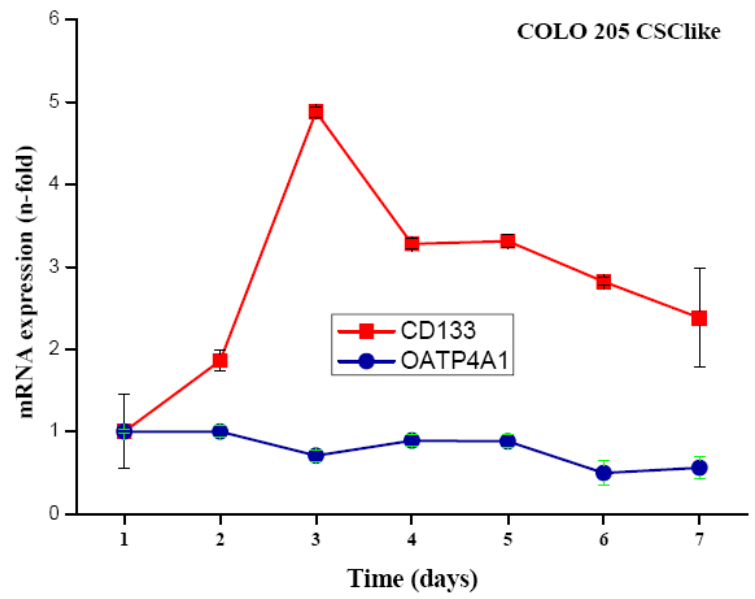
Figure 1. Expression of CD133 and OATP4A1 mRNA in serum-free stem cell medium. Time course of real-time qPCR of CD133 and OATP4A1 expression in COLO205 colon cancer cells cultivated in serum-free stem cell medium for the indicated period of time (mean ± SD). Expression of CD133 was significantly increased at days 2–7.